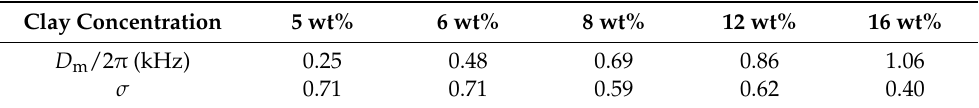
Figure 7. ( a ) Normalized DQ (nDQ) signal intensity as a function of DQ excitation time for the HTPB28/C18-clay nanocomposites with different clay concentrations (the solid lines are numeric fitting results via Equation (6) in the Supplementary Materials); ( b ) D res distribution curves obtained from the numeric fitting on the nDQ curves in ( a ); ( c ) nDQ signal intensity as a function of DQ excitation time for the HTPB28/C18-clay-8 wt% nanocomposite in different states—initial state (black), after shear (red), and recovery at 60 °C for 12h after shear (blue) (the solid lines are numeric fitting results via Equation (6) in the Supplementary Materials); ( d ) D res distribution curves obtained from the numeric fitting on the nDQ curves in ( c ). All experiments were performed at 30 °C. Table 1. D m and σ obtained from the fitting of the corresponding nDQ buildup curves of HTPB28/C18-clay nanocomposites with different clay concentrations by assuming a log-normal distribution for D res .